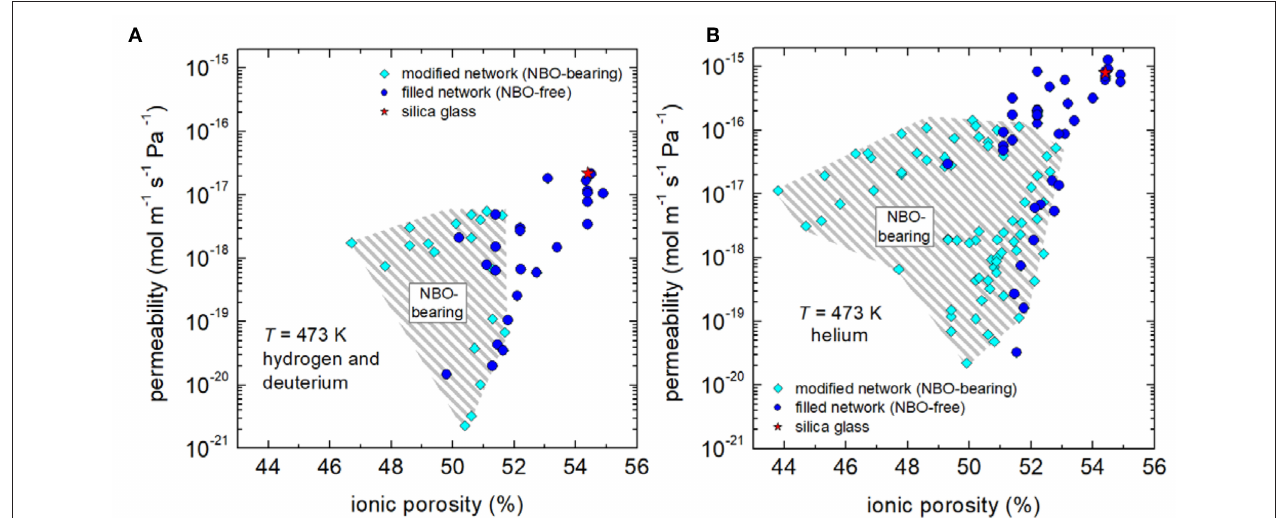
FIGURE 3 | Isothermal hydrogen/deuterium (A) and helium (B) permeability vs. ionic porosity. Data are from the compositions collected by Shelby (1996) (commercial silica and borosilicate glasses), Shelby (1973), Shelby (1974a), Shelby (1977b), Shelby and Lapp (1993), Lapp and Shelby (1997) (binary alkali silicate glasses), Ried et al. (2014) (aluminosilicate and borosilicate glasses), Tsugawa et al., 1976) (alkali-alkaline earth silicate glasses), Shelby and Eagan (1976), Shelby (1977b), Welter et al. (2019) , Marzok (2019) (aluminosilicate glasses). Mean value for silica glass is labeled with a red star. Note that for calculation of V M at 473K available data of thermal expansion were utilized [SciGlass (http://www.akosgmbh.de/sciglass/sciglass.htm)].